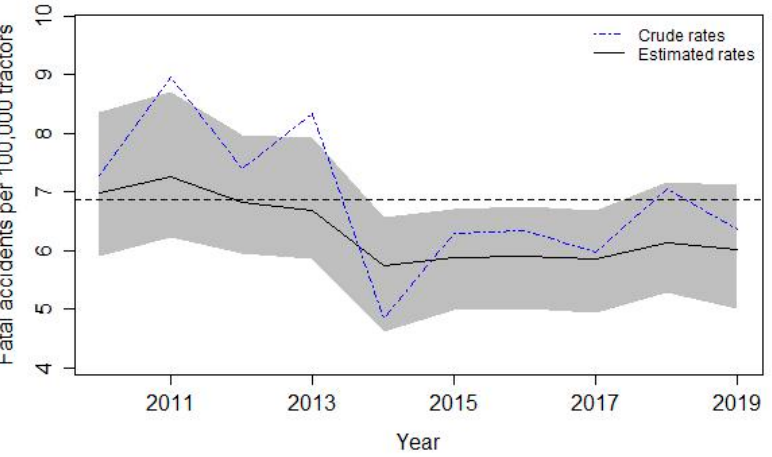
Figure 1. Temporal evolution of year-specific tractor fatal accident crude rates (blue dashed line) and estimated rates (black solid line) with 95% credible intervals bands (shaded area). The overall rate for Spain (black dashed line) is also included as a reference value.